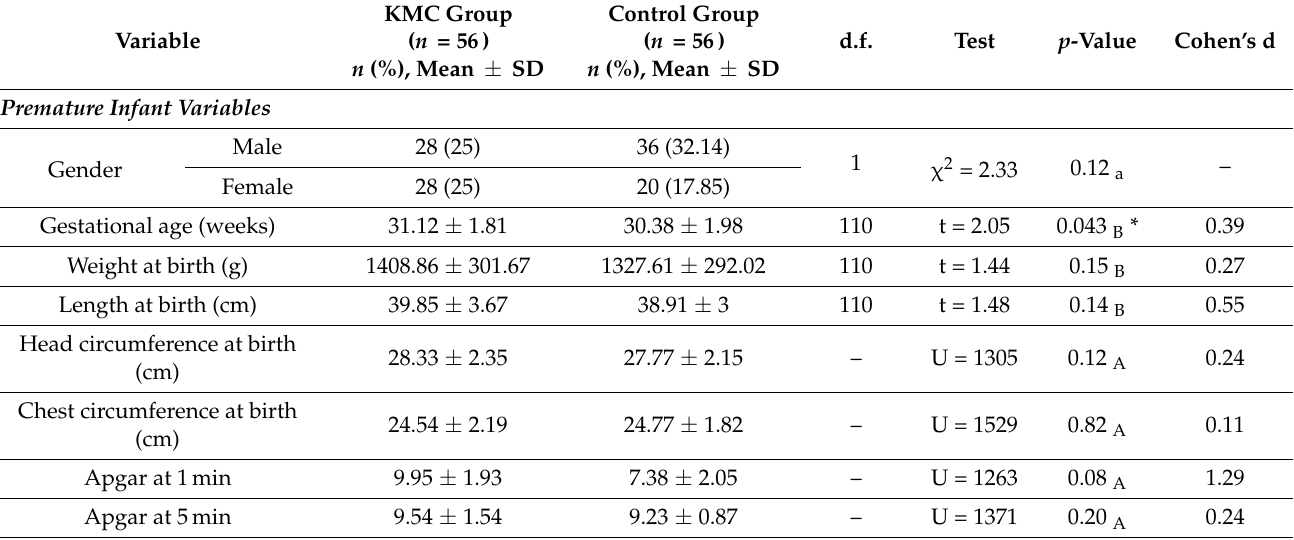
Table 1. Description of Infant and Maternal Clinical and Demographic Characteristics of KMC and control